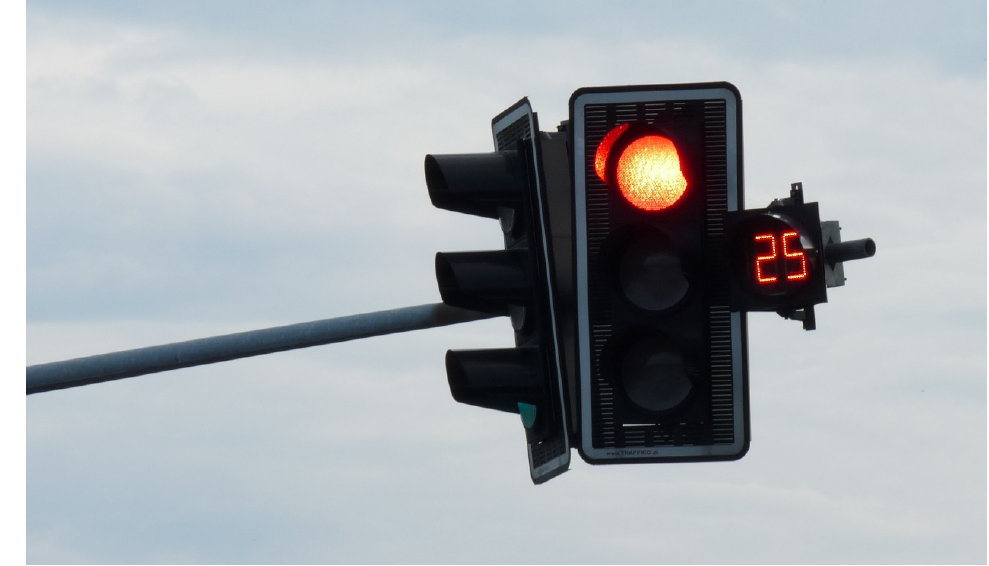
Figure 1. Signal Countdown Timer in Nowy S ą cz, Poland (2016).